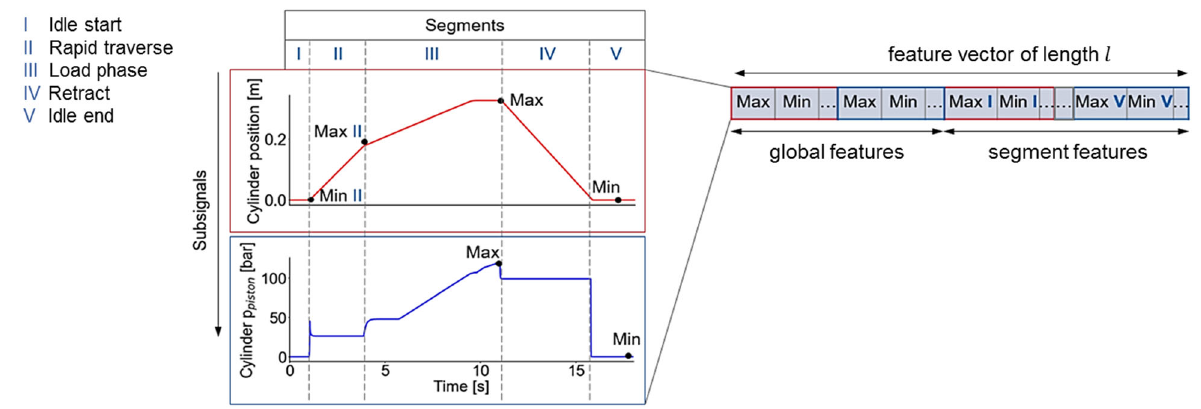
Figure 6. Concept of adding segment features to the base set of global features shown for two subsignals and the features “maximum” and “minimum”.